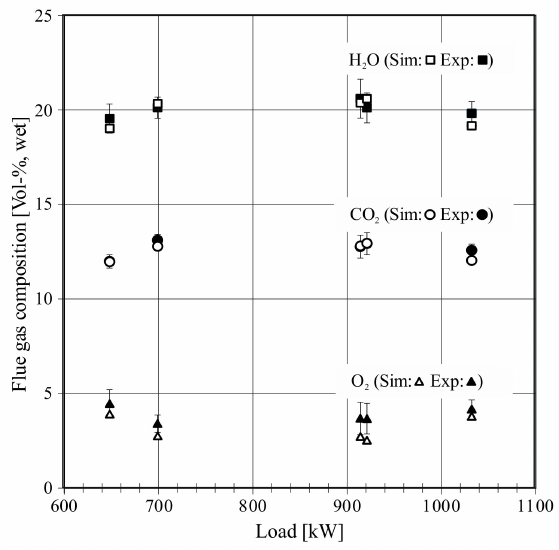
Figure 10. Flue gas composition at part load.